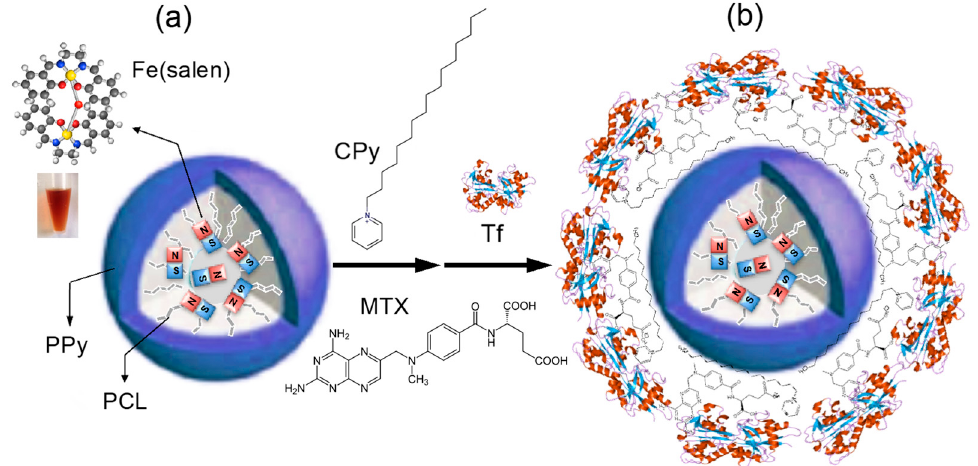
Figure 1. Synthesis of magnetic nano-hybrids functionalized with MTX and apo-transferrin (Tf) proteins as a surface stabilizer and cancer marker. ( a ) Fe(salen) molecules are loaded into PPy- b -PCL copolymers to form a core-shell nanoassembled NP. ( b ) MTX molecules are covalently functionalized onto the NP surface in the presence of CPy, followed by a colloidal stabilization via a transferrin coating.